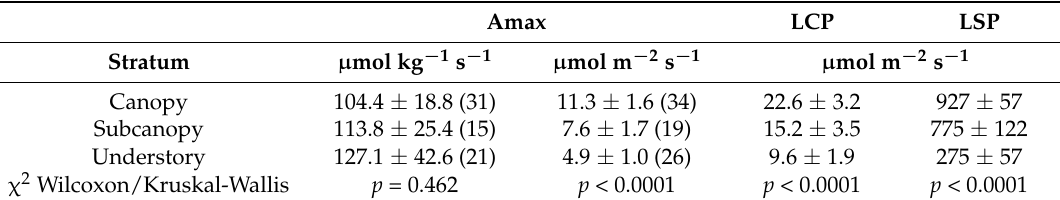
Table 2. Median ± Median Absolute Deviation (number of observations) for the main photosynthetic parameters in the Castilla forest at El Tallonal. Medians differed between group of species per stratum, except for A max per unit mass.